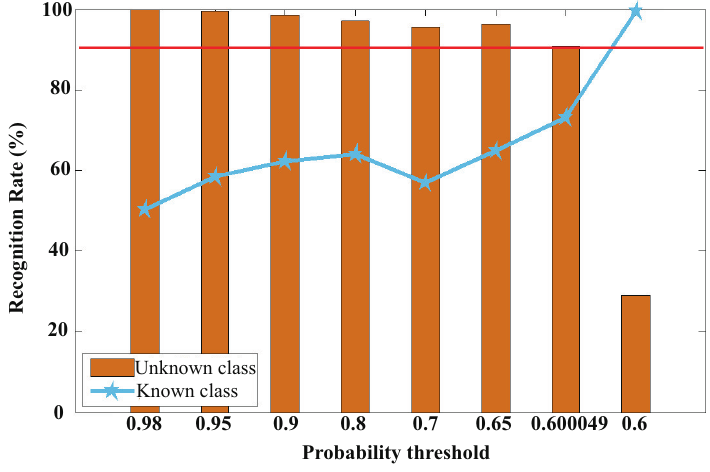
Figure 14. Recognition rate of the OvR-SVM algorithm for OCC.